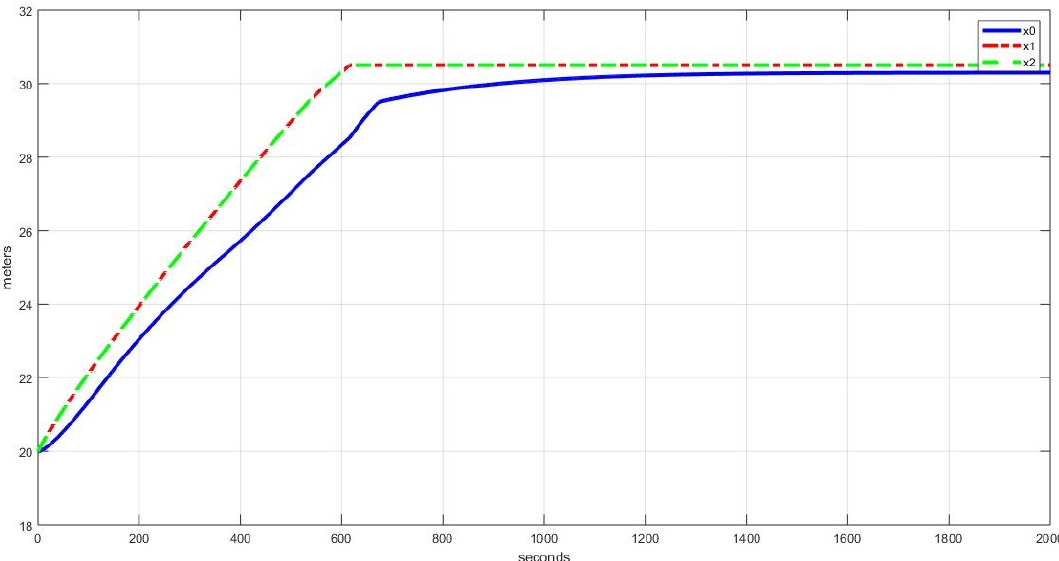
Figure 7. Pond levels (0, 1, and 2) in normal operation at the desired power of 1.65 MW.